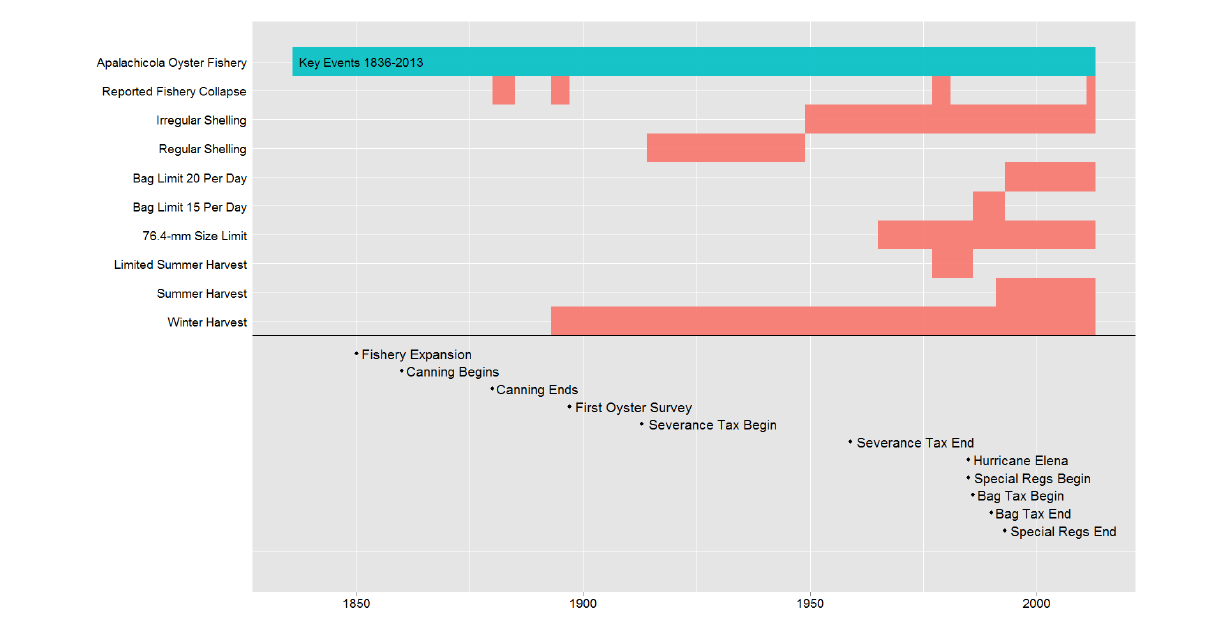
Fig. 2 . Time line of key events and management actions in the Apalachicola Bay, Florida oyster fishery, 1836-2013.